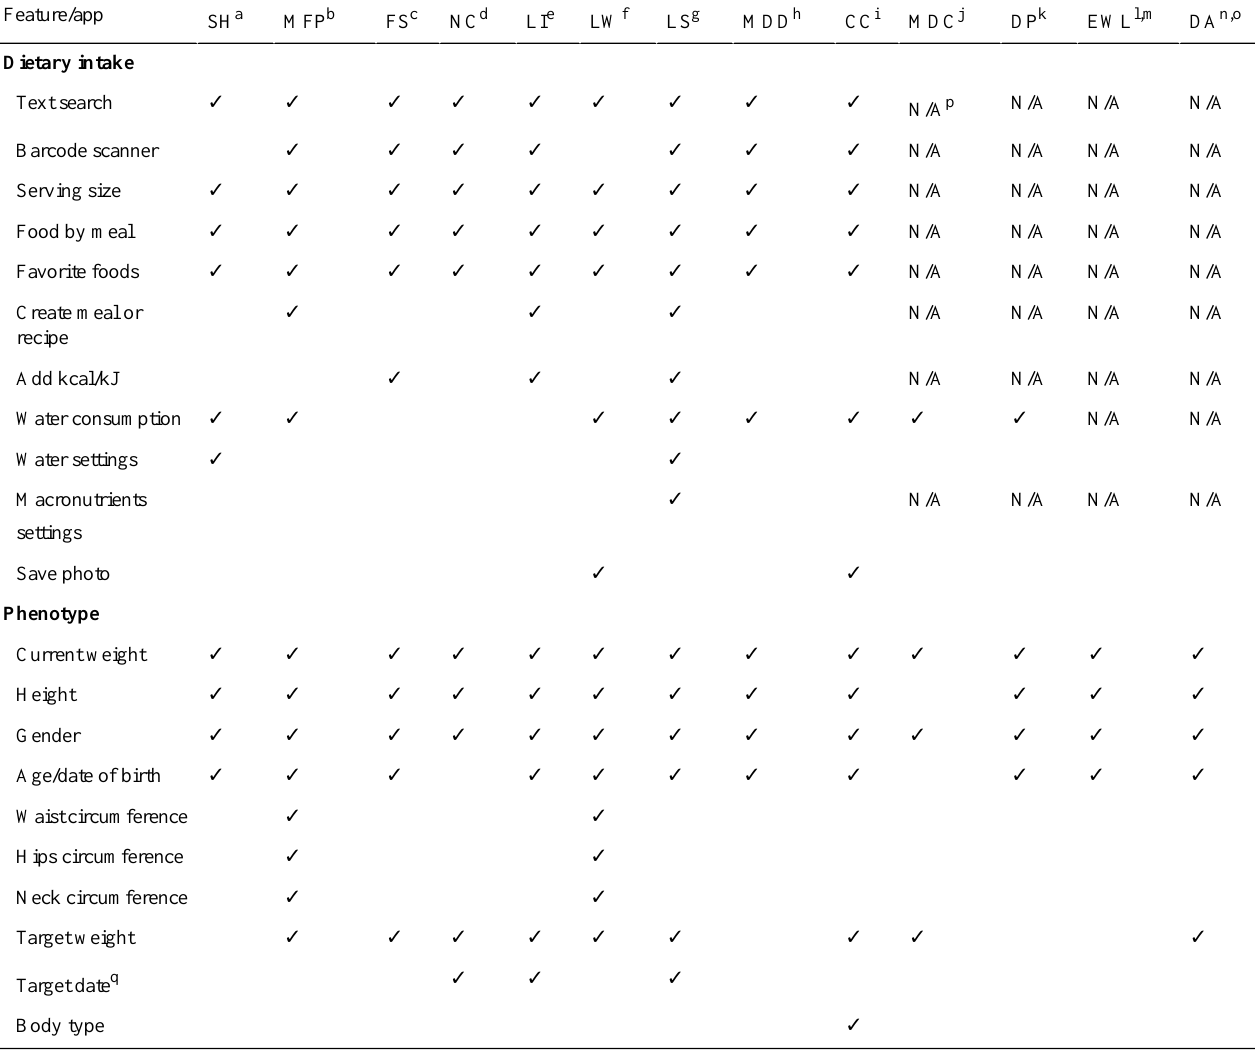
Table 3. Nutrition-related app input features for dietary intake and